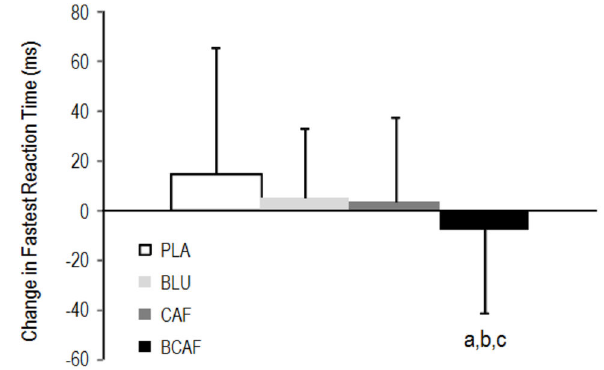
Figure 2. Change in performance of the visual Go/No-Go psychomotor task. a: small difference from BLU, b: small difference from CAF, c: moderate difference from PLA. PLA: white light/placebo; CAF: white light/240 mg caffeine; BLU: blue light/placebo; BCAF: blue light/240 mg caffeine.